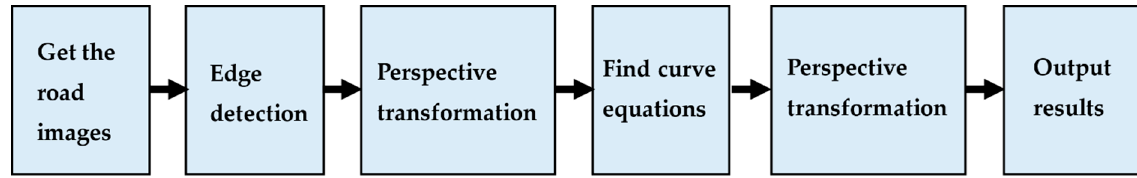
Figure 12. Steps of lane line detection.